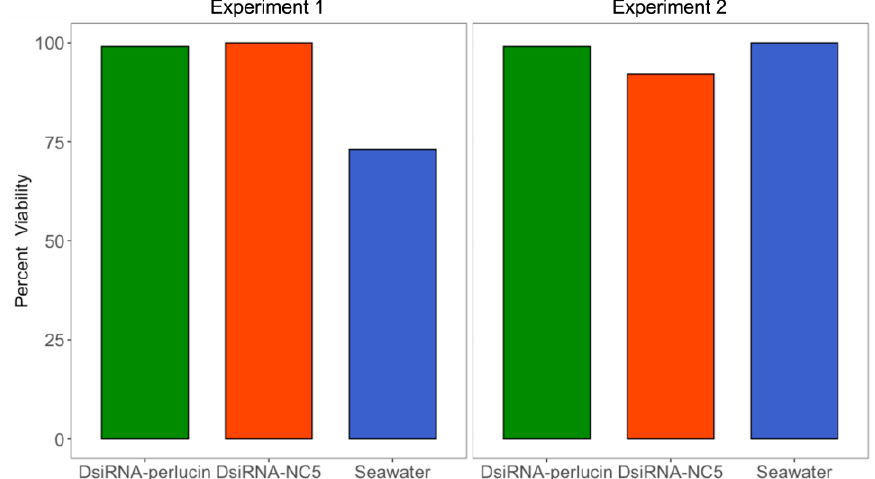
Figure 1. Viability of larvae post-transfection (after 4 h for Experiment 1 and 24 h for Experiment 2) and prior to exposure to p CO 2 treatments was assessed. Transfection of DsiRNAs (gene silencing (green) and negative control (orange)) did not induce mortality and larval viability was similar to those without transfection (blue). There are no error bars or statistics performed because all replicates were pooled for the transfection step.